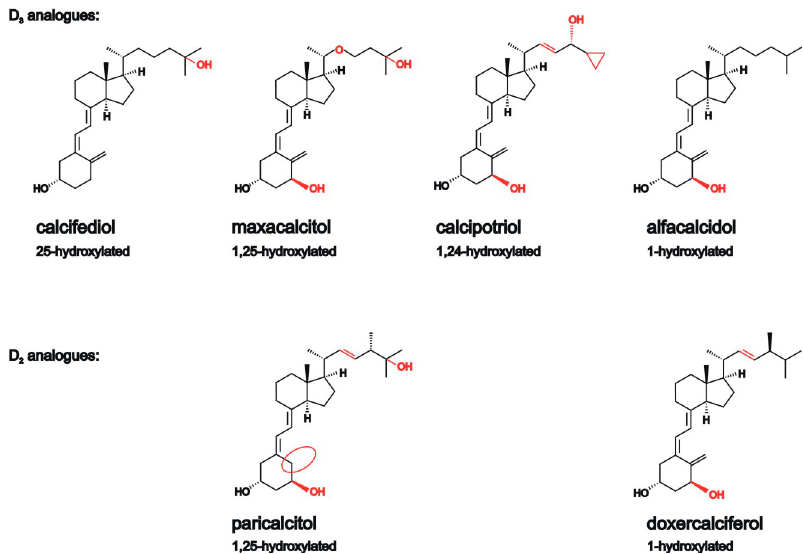
Figure 1. Chemical structure of 25(OH) vitamin D 3 and different vitamin D analogues. Structural changes between the analogues are highlighted in red or with red cycles.